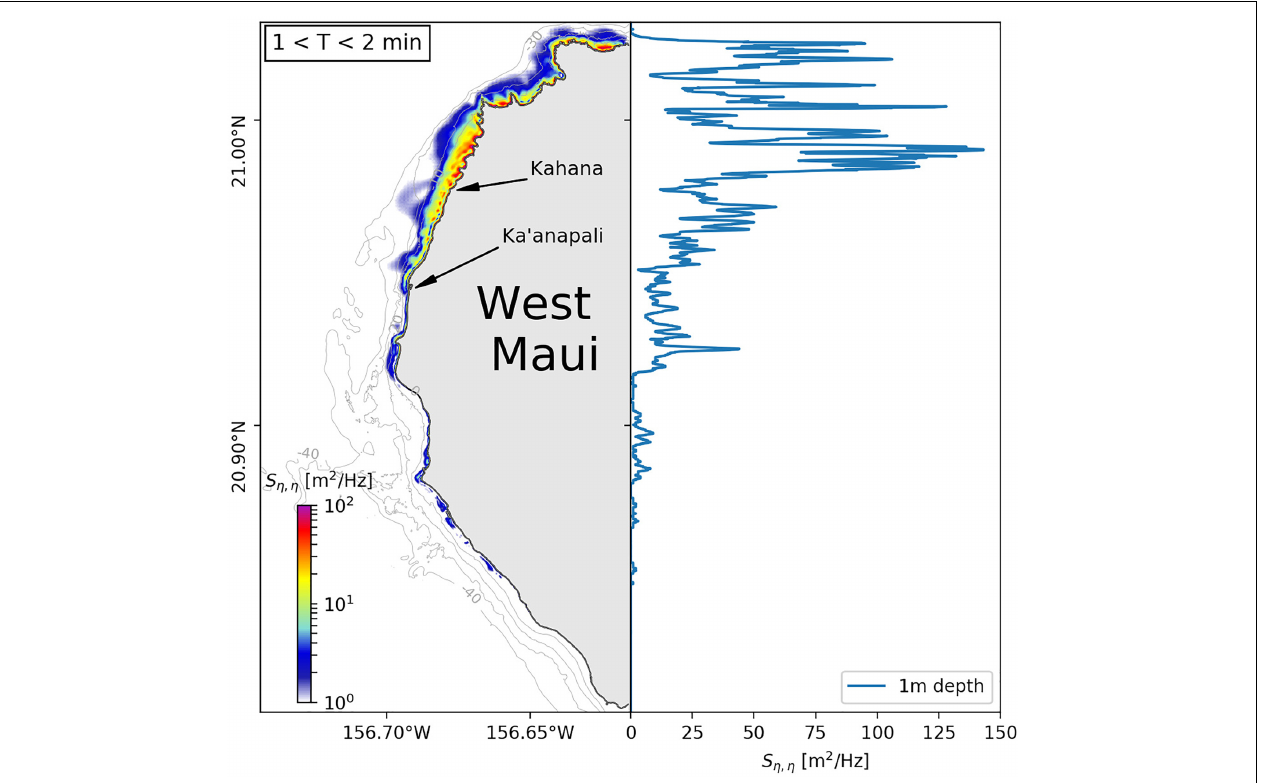
FIGURE 2 | Left panel: Map of computed power spectral density (PSD) along the West Maui coastline from the BOSZ model, in the 1–2 min IG band. Right panel: The corresponding PSD levels along the 1 m depth contour line. The sea/swell input conditions are from due north with H s = 2 m and T p = 16